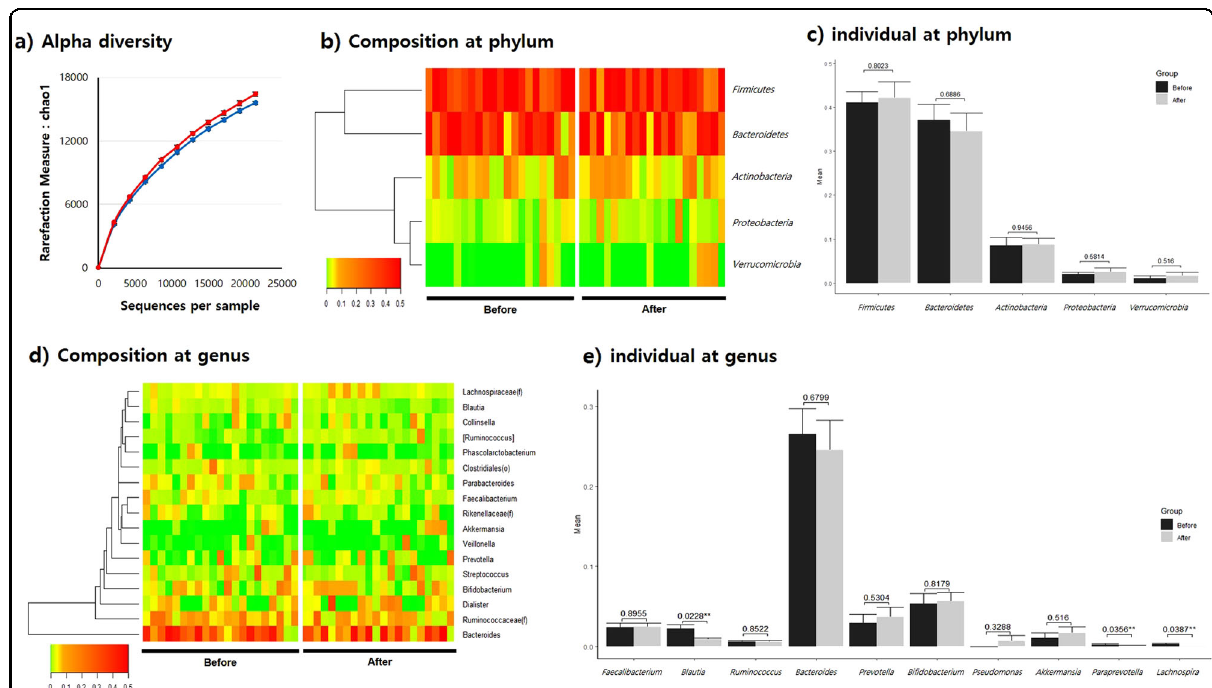
Fig. 1 Composition of stool bacteria before and after consumption of a synbiotic beverage. a Alpha diversity measured by Chao1, b composition of the microbiome at the phylum level, c individual microbiome at the phylum level, d composition of the microbiome at the genus level, and e individual microbiome at the genus